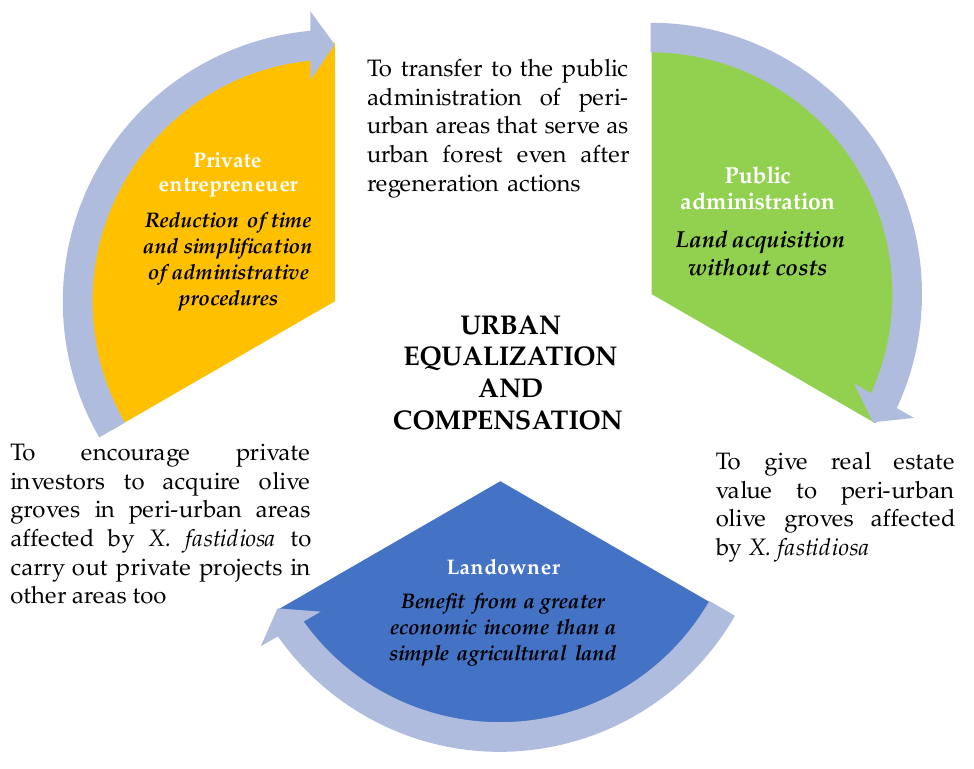
Figure 10. Conceptual model of management of areas affected by X. fastidiosa .